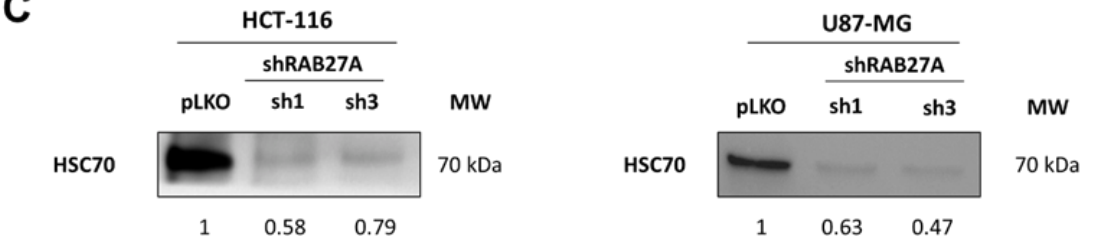
Figure 1. Validation of the shRAB27A models in both HCT-116 and U87-MG cell lines. ( A )—Downregulation of RAB27A expression was evaluated by RT-qPCR in both pLKO (control) and shRAB27A cell lines. Whatever the cell line, sh1 and sh3 showed the strongest impairment in RAB27A expression compared to pLKO. The Mann–Whitney test was used for evaluation of the significance; * p < 0.05; *** p < 0.001 n = 6. ( B )—Downregulation of RAB27A expression was evaluated by Western blot in HCT-116 and U87-MG models (left panels). The quantification of RAB27A expression (right panel) was consistent with RT-qPCR analysis. The Mann–Whitney test was used for evaluation of the significance; * p < 0.05; ** p < 0.01; *** p < 0.001; n = 6. ( C )—Western blot analysis showed a decreased expression of HSC-70 in purified exosomes from both cell lines when RAB27A was down regulated; n = 3.